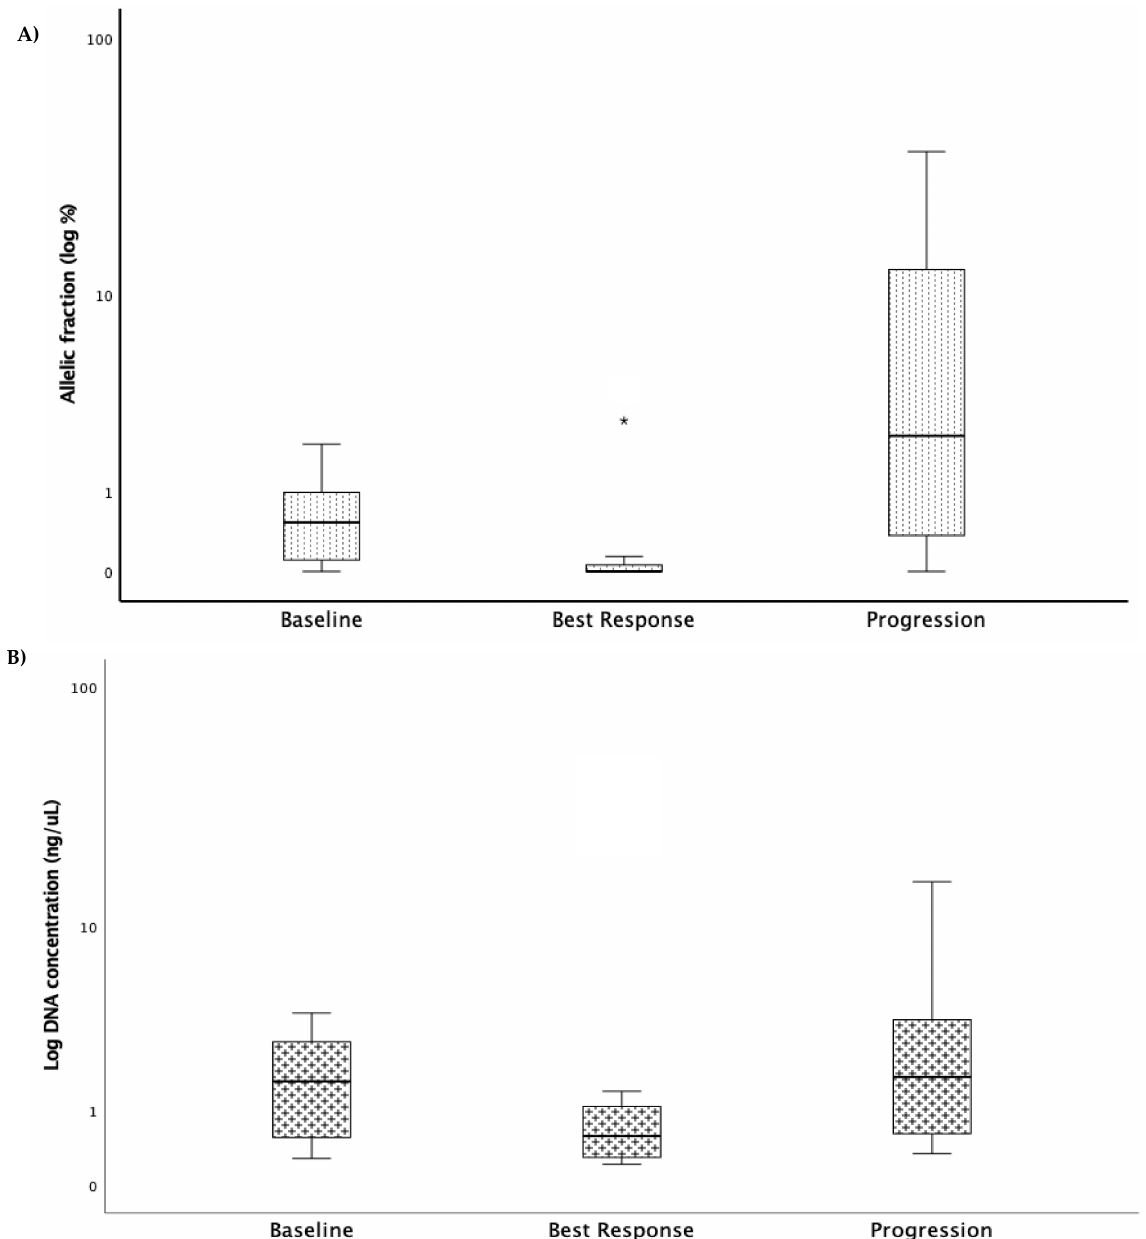
Figure 2. Box plots depicting the detectable variants of the mutated genes ( A ) and cfDNA concentration ( B ) at baseline, best response, and progression. Box represents the interquartile range of values and whiskers the median and the 25th and 75th percentile values ( n = 13, * p = 0.001, Kruskal–Wallis test). The allelic fraction decreased to its lowest level at best response to treatment and increased to its highest level when the disease progressed.